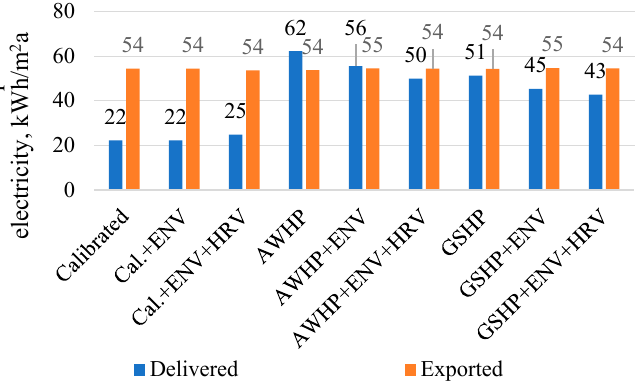
Figure 7. Exported/delivered electricity unit load from PV for ( a ) general and AWHP cases and ( b ) GSHP cases.